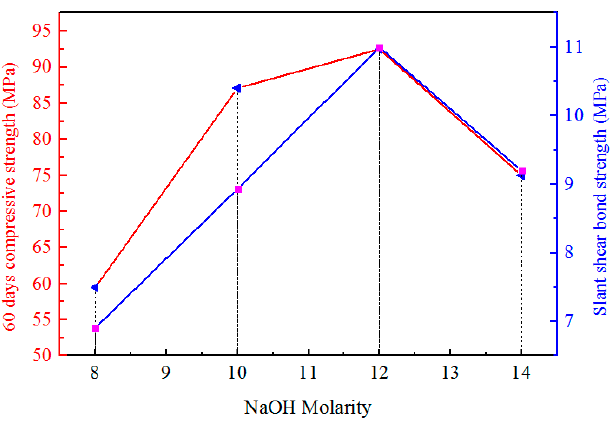
Figure 7. The relationship between overlay FA-based geopolymer paste compressive strength and slant shear bond strength.